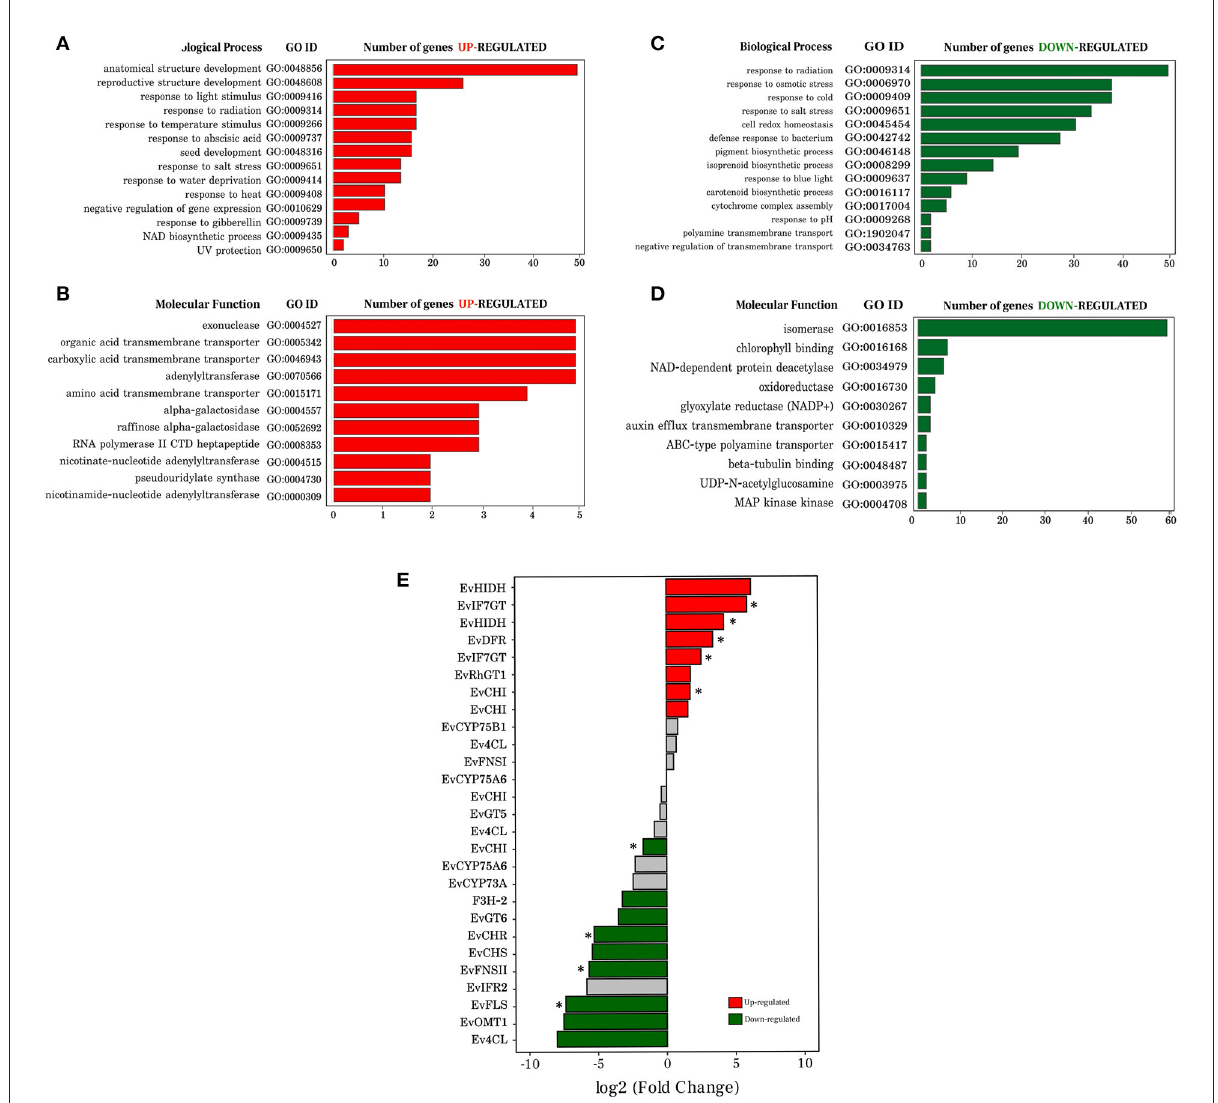
FIGURE3 Gene ontology analysis of differentially expressed transcripts and expression profile of transcripts involved in the flavonoid biosynthesis pathway in Erythrina velutina . (A,B) Representation of the biological processes and molecular function, respectively, of the up-regulated transcripts. The ontology name, gene ID and amount of transcript identified in each GO term are also shown; (C,D) Representation of the biological processes and molecular function, respectively, of the down-regulated transcripts. The ontology name, gene ID and amount of transcript identified in each GO term is also depicted; (E) Bar graph representing the transcripts identified and involved in the flavonoid biosynthesis pathway. Transcripts marked in red and green bars, indicate that they were up- and down-regulated, respectively; transcripts represented by gray bars had no changes. Bars marked with an asterisk indicate that they have adjusted p < 0.01, unmarked bars have adjusted p <